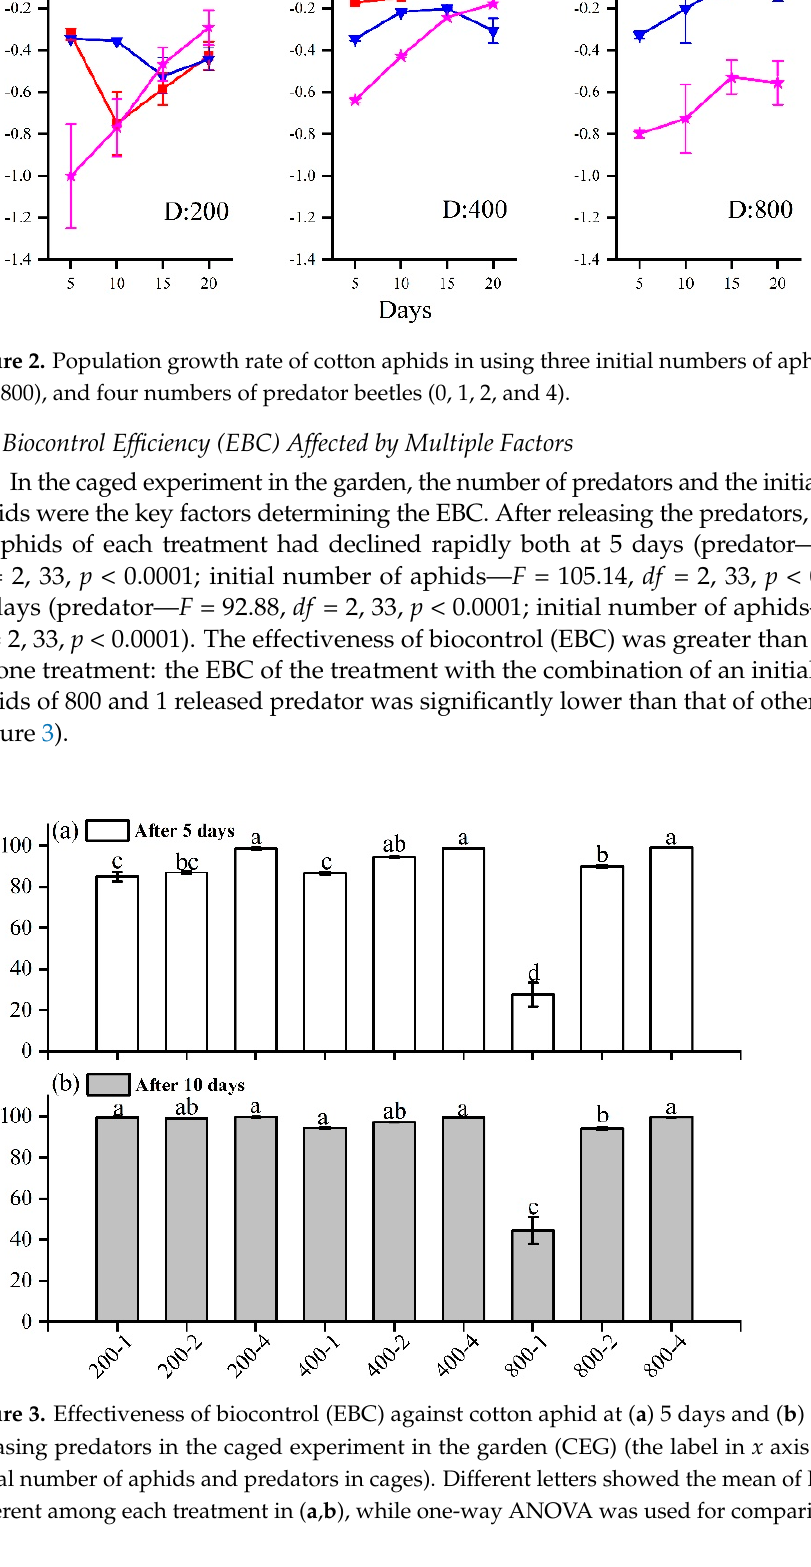
Figure 1. Population growth rate of cotton aphids in laboratory experiments using three initial num- bers of aphids (200, 400, and 800), four numbers of predator beetles (0, 1, 2, and 4), and three constant temperature regimes (24 °C, 27 °C, and 30 °C).